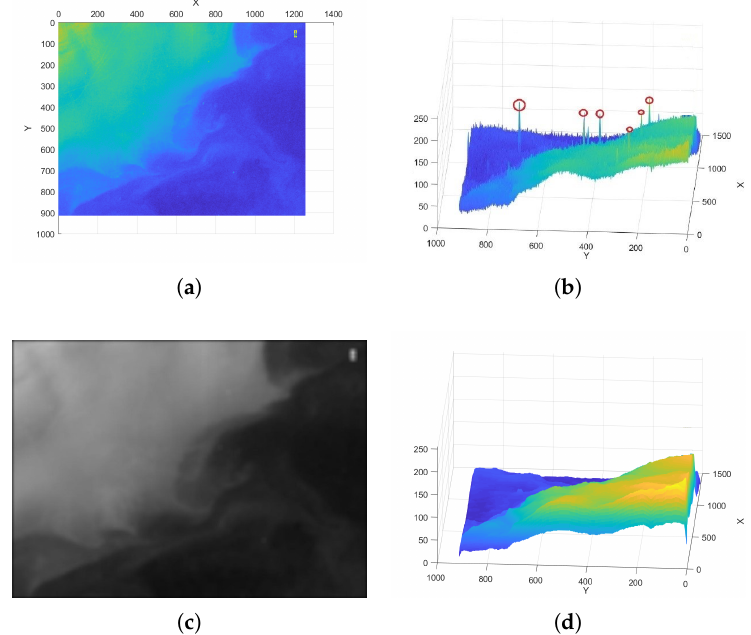
Figure 5. ( a ) is the grayscale distribution of Figure 1b, ( b ) is the grayscale three-dimensional distribution of Figure 1b, ( c ) is the image after mean filtering, and ( d ) is the grayscale three-dimensional distribution of ( c ). The x and y axes represent the pixel coordinates of the image, and the z axis represents the gray value of the